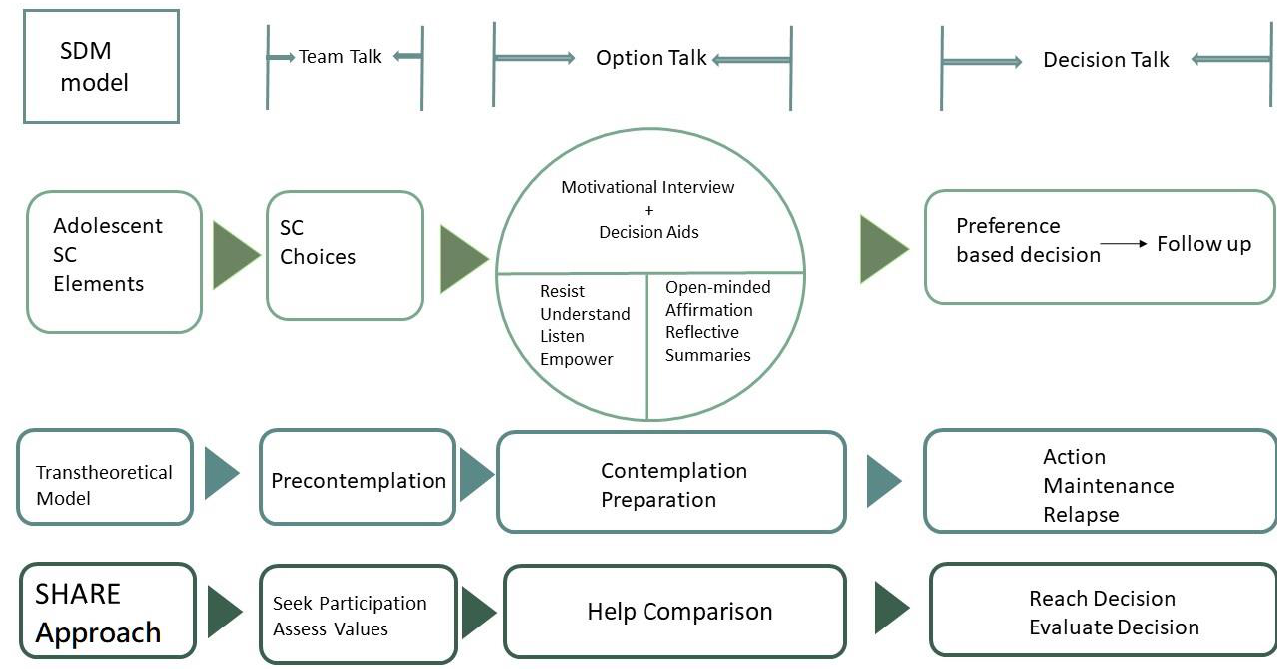
Figure 1. Framework of shared decision-making model for adolescent smoking cessation (SC).